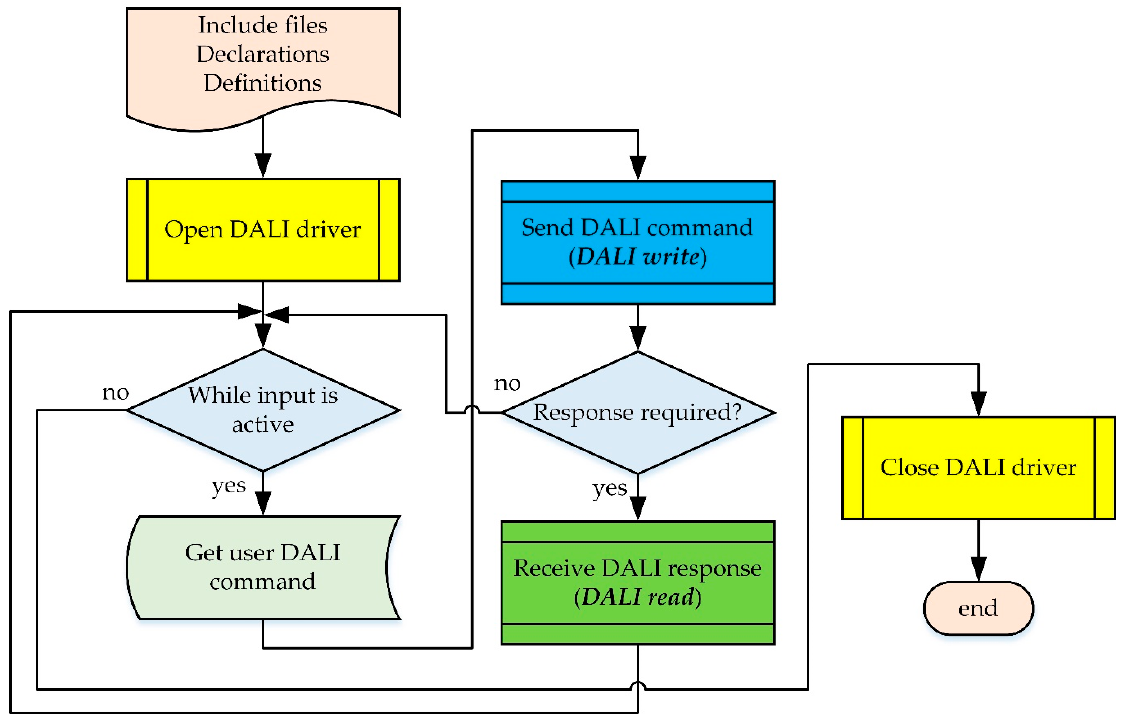
Figure 7. DALI template application program flow.